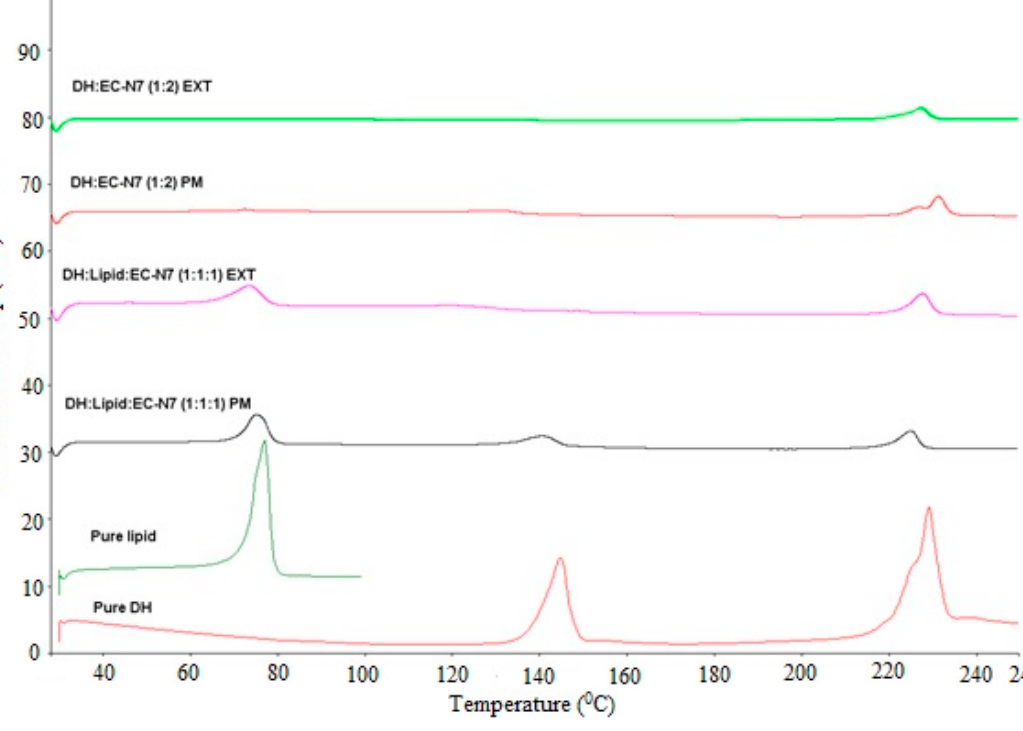
Pharmaceutics 2021 , 13 , x FOR PEER REVIEW Figure 3. DH/C-888 DSC studies performed at temperatures of 30–250 °C and a heating rate of 20 °C/min. Figure 3. DH/C-888 DSC studies performed at temperatures of 30–250